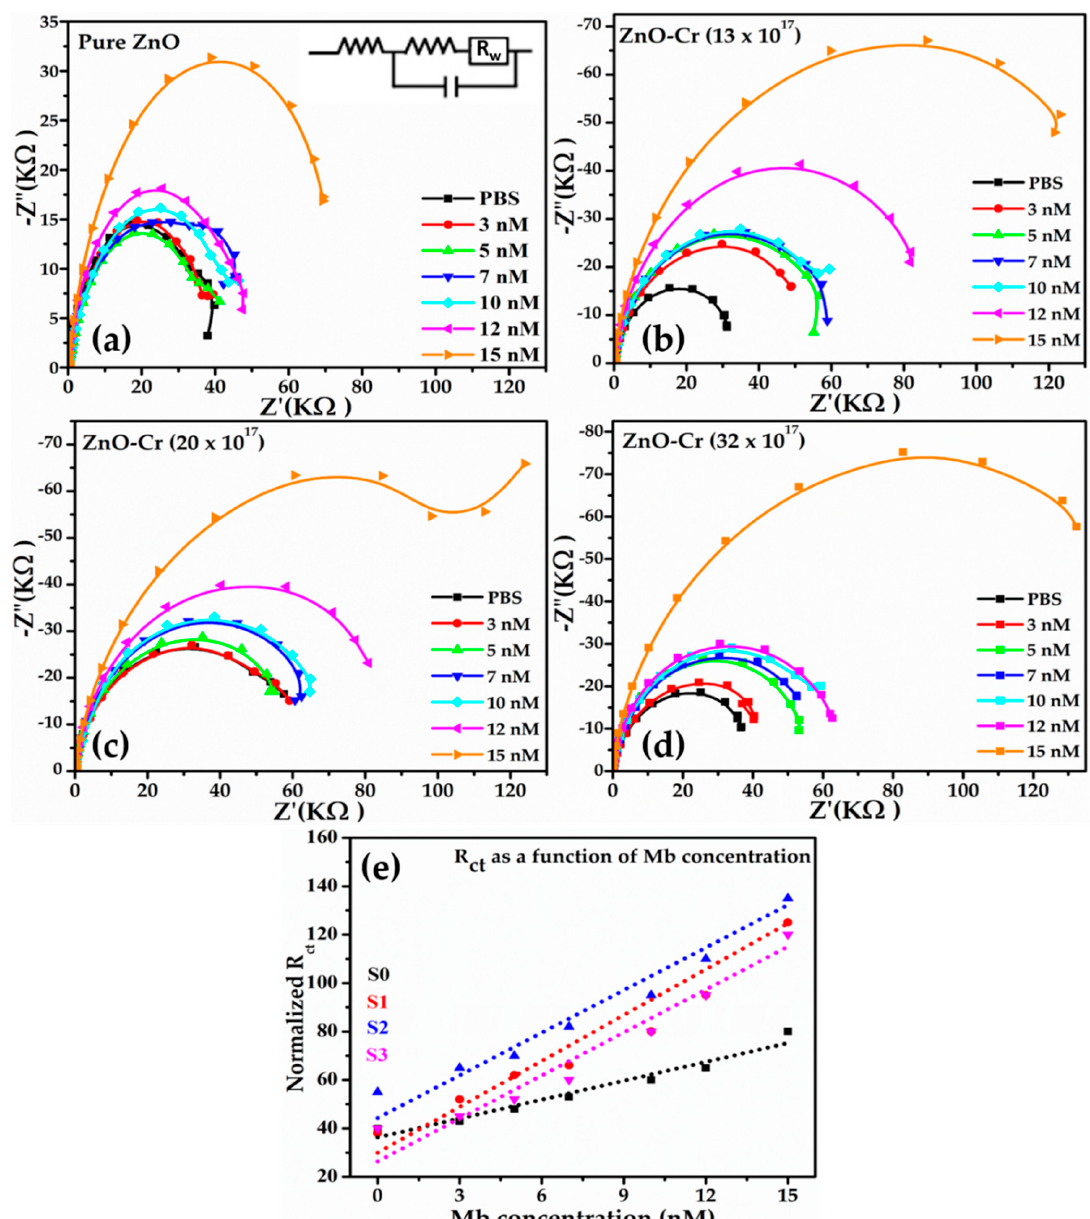
Figure 7. Series of Nyquist plots acquired for different Mb concentrations. ( a ) Pure ZnO; ( b ) ZnO-Cr (13 × 10 17 atoms/cm 3 ); ( c ) ZnO-Cr (20 × 10 17 atoms/cm 3 ), ( d ) ZnO-Cr (32 × 10 17 atoms/cm 3 ), and ( e ) R ct values for different Mb